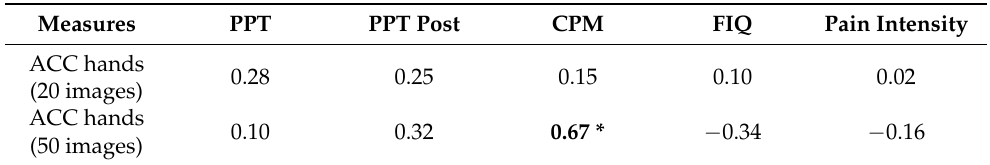
Table 4. Correlation coefficients between performance on the lateral recognition and psychophysio- logical